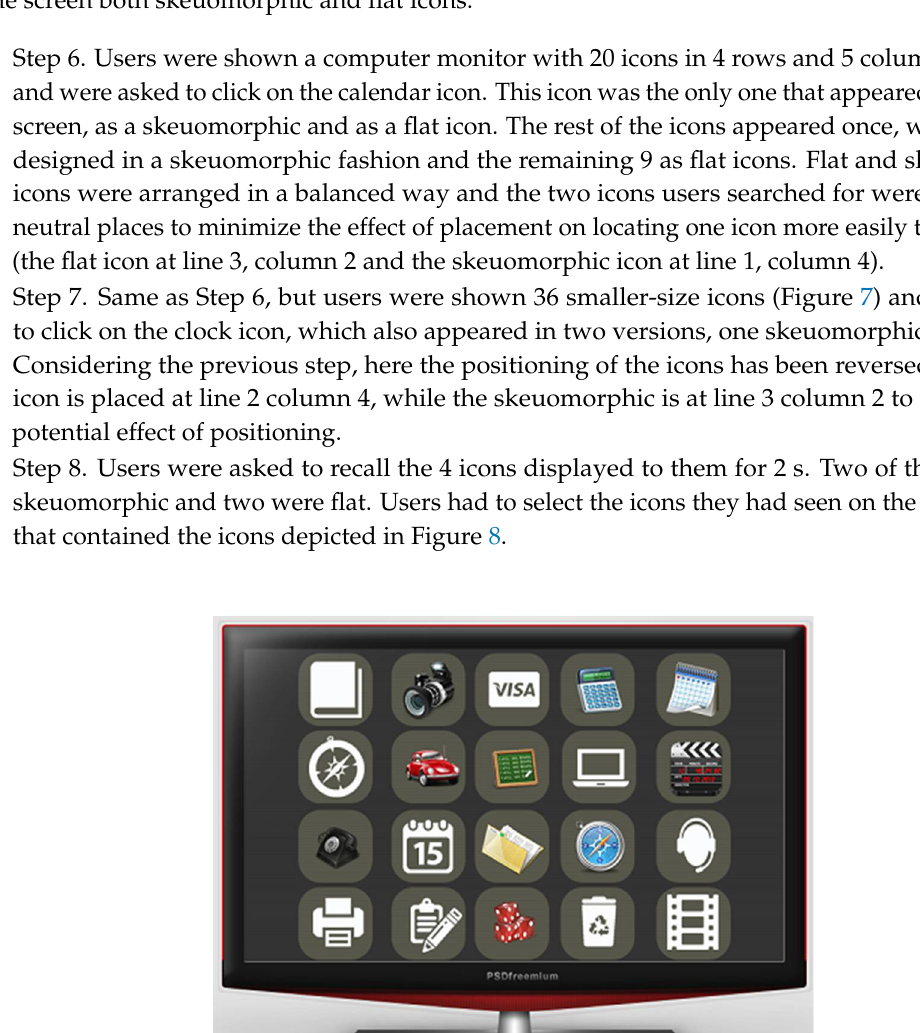
Figure 5. Icon sets displayed to users in Step 5 (recall as many as possible).